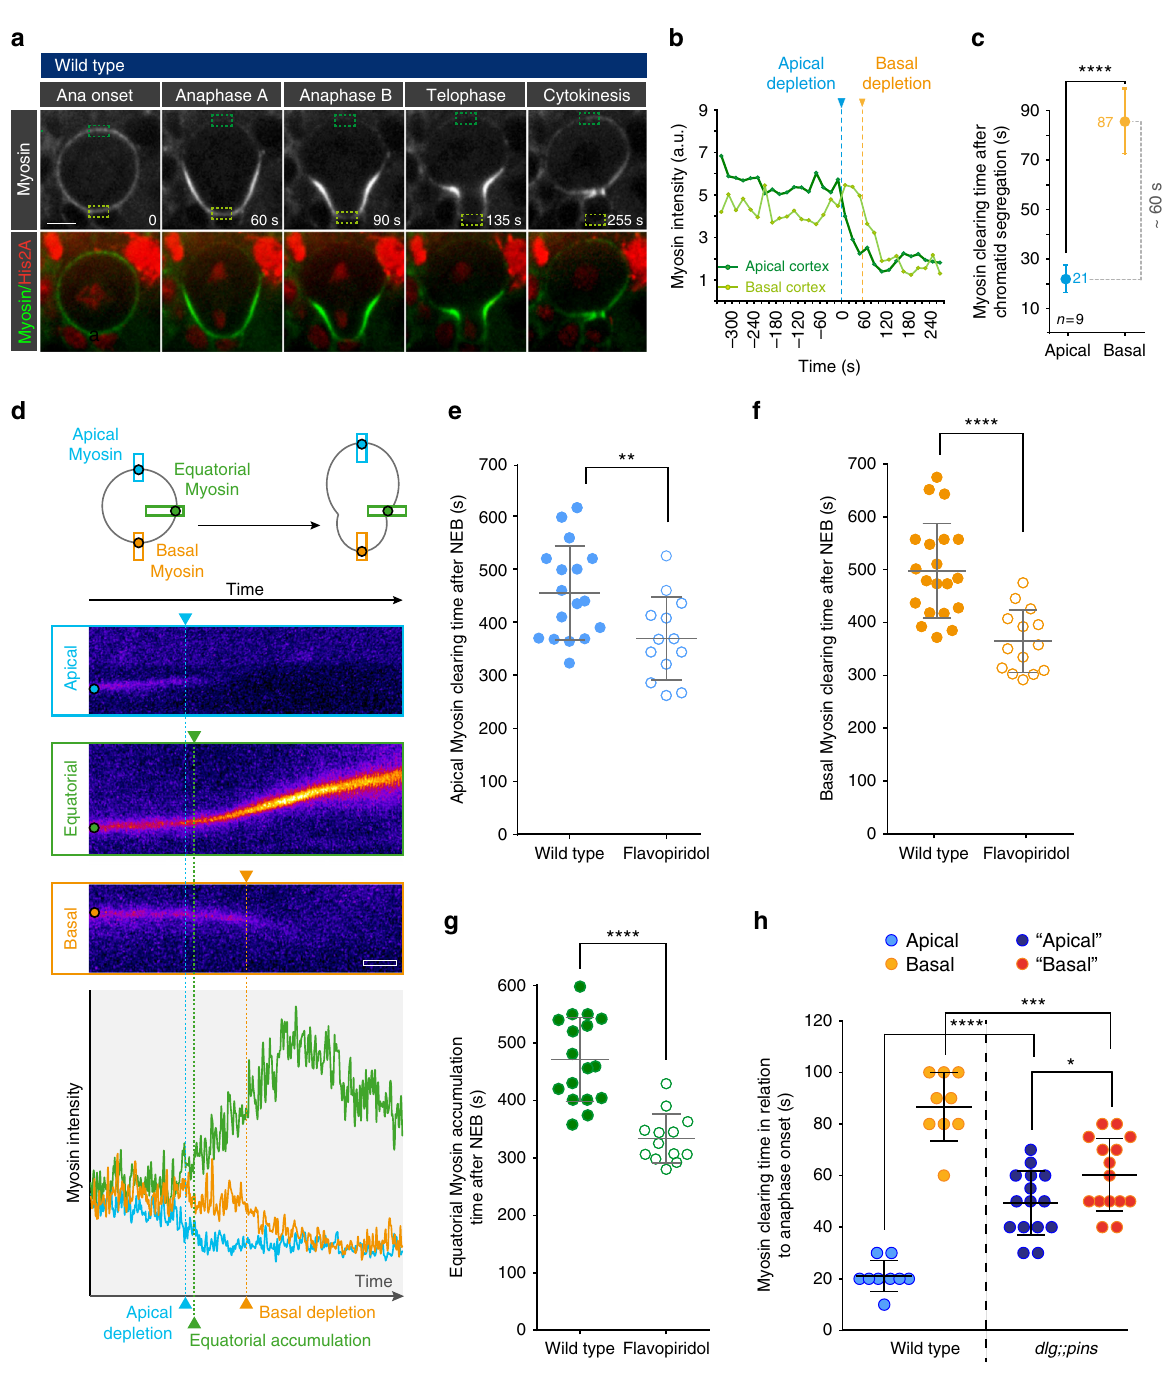
Fig. 1 Cell cycle and polarity cues regulate Myosin ’ s dynamic relocalization. a Representative image sequence showing a wild-type neuroblast expressing Sqh::GFP (Myosin, white; top row, green; bottom row) and the DNA marker His2A::mRFP (red; bottom row). Cortical Myosin intensity was measured at the apical (dark green dashed box) and basal cortex (light green dashed box) throughout mitosis and plotted in b . Chromatid segregation starts at “ 0 s ” . c Mean apical and basal Myosin clearing time and standard deviation in relation to chromatid segregation. The blue and orange numbers represent the mean value. d Kymographs showing Myosin intensity at the apical (blue boxes), lateral (green boxes) and basal neuroblast cortex (orange boxes) for one representative wild-type neuroblast. Kymographs were generated from high temporal resolution time-lapse movies (2 s acquisition time). The graph shows Myosin intensity at the apical (blue plot), lateral (green plot) and basal cortex (orange plot). Apical e basal f Myosin clearing time after nuclear envelope breakdown (NEB) in control and Flavopiridol-treated neuroblasts. g Equatorial Myosin accumulation time after NEB. h Scatter plot showing the apical and basal Myosin clearing time in relation to anaphase onset, for wild-type and dlg;;pins mutant neuroblasts. For this and all subsequent fi gures: since polarity is lost in dlg;;pins mutants, we refer to the cortex clearing slightly earlier or associated with the slightly bigger cell as “ apical ” , whereas the other cortex is referred to as “ basal ” . Center values and error bars represent the mean and standard deviation (s.d), respectively. Asterisks denote statistical signi fi cance, derived from unpaired t-tests: * p ≤ 0.05, ** p ≤ 0.01, *** p ≤ 0.001, **** P ≤ 0.0001. Each measured cell (n) is represented with a dot in the scatter plots. For other graphs, the number of measured cells is indicated in the corresponding panels. For each experiment, the data was collected from at least 3 independent experiments. For each independent experiment, at least 5 larvae were dissected. Time: seconds (s). Scale bar: 5 µ m. Time scale bar (open white box) in (d): 20 s. n.s. not signi fi